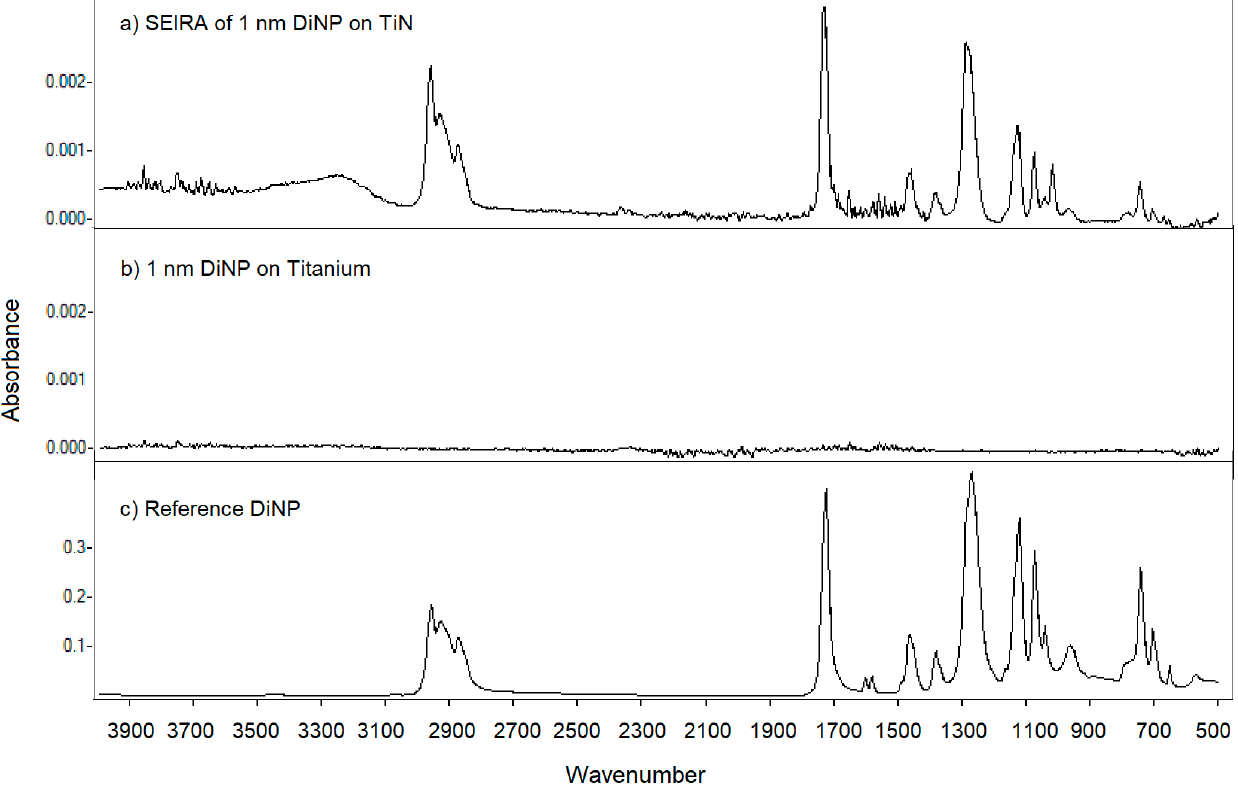
Figure 4. ( a ) The surface-enhanced infrared absorption (SEIRA) spectrum for a 1-nanometer film of diisononylphthalate (DiNP) cast on TiN. ( b ) DiNP cast on bare titanium showing no enhancement. ( c ) Reference spectrum of DiNP.